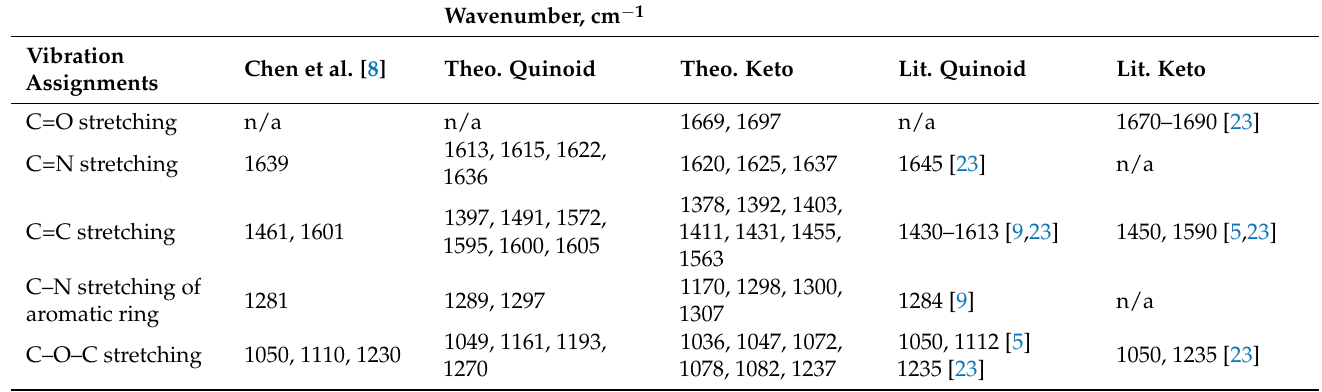
Table 1. Major peak descriptions for DBD plasma-produced PoAP, theoretical & literature values for quinoid and keto